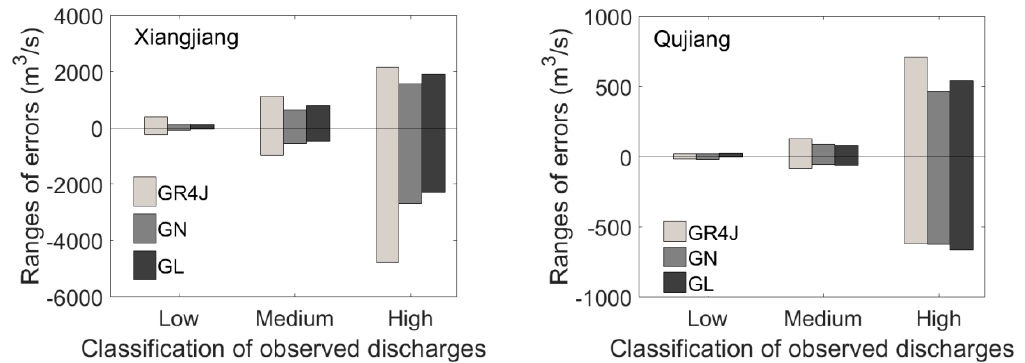
Figure 4. Ranges of forecasting errors in high, medium, and low flows in the Xiangjiang and Quajiang River basins.